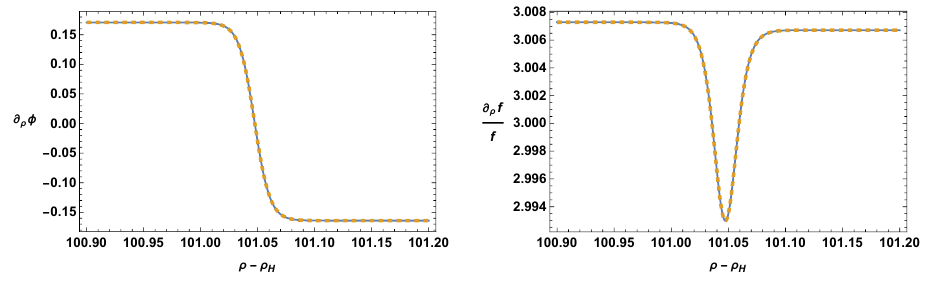
Figure 4: Evolution of ˙ φ (left) and ˙ f / f (right) across a bounce. Orange dashes are the full numerical solution (cf. inset of Fig. 2 for ˙ f / f ). Solid blue lines show